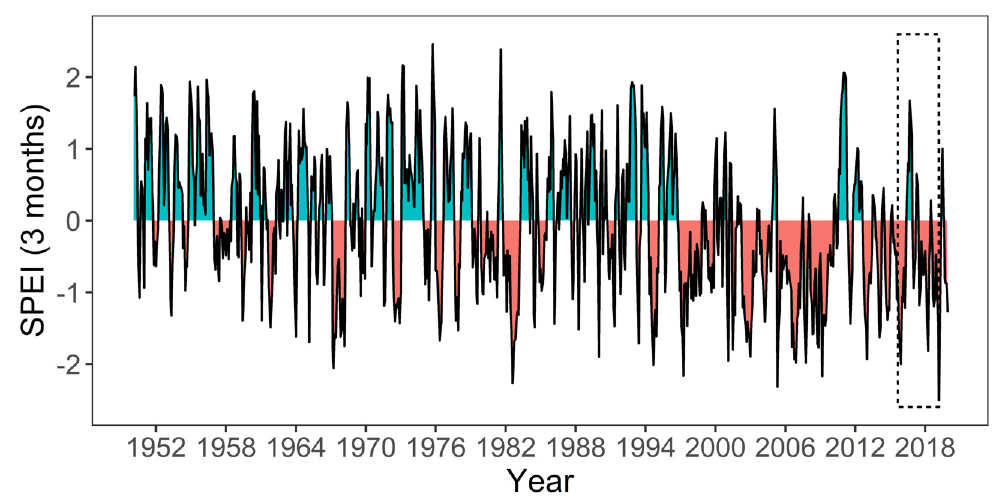
Figure 1. Monthly Standardized Precipitation Evapotranspiration Index (SPEI) averaged over three months from 1950 to 2019 (0.5° gridded SPEI range between − 37.25 and − 37.75 latitude and 144.25 longitude, calibration period from 1950 to 2010). Shaded box represents the study period.